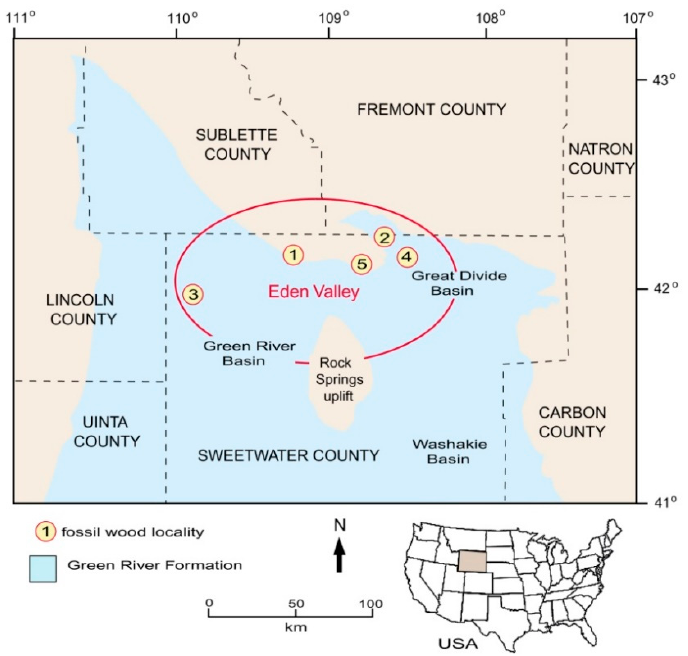
Figure 2. Fossil wood localities: (1) Big Sandy Reservoir; (2) Oregon Buttes; (3) Blue Forest; (4) Parnell Draw; (5) Hay’s Ranch.